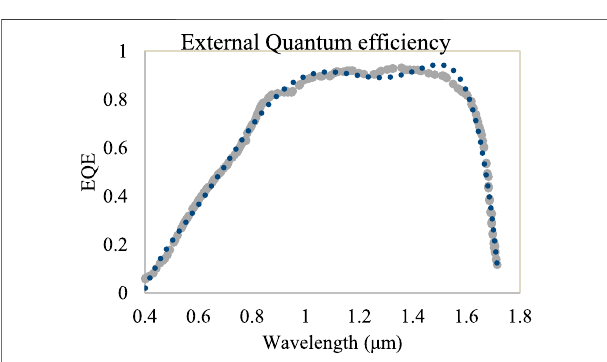
FIGURE 5 | Experimentally measured data and curve of best fi t for the 0.25 cm 2 n-p InGaAs cell (Tuley et al., 2012).